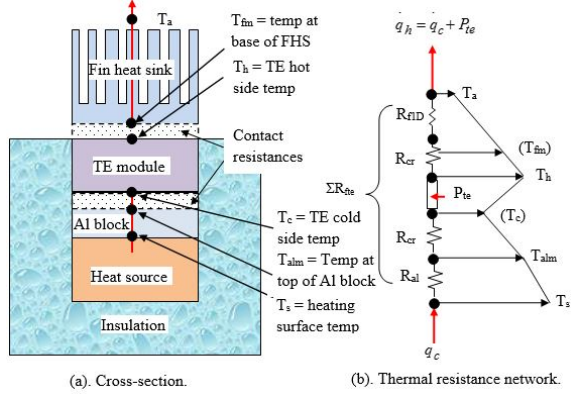
Figure 3. Thermal resistance model of the FHS ‐ TE assembly.